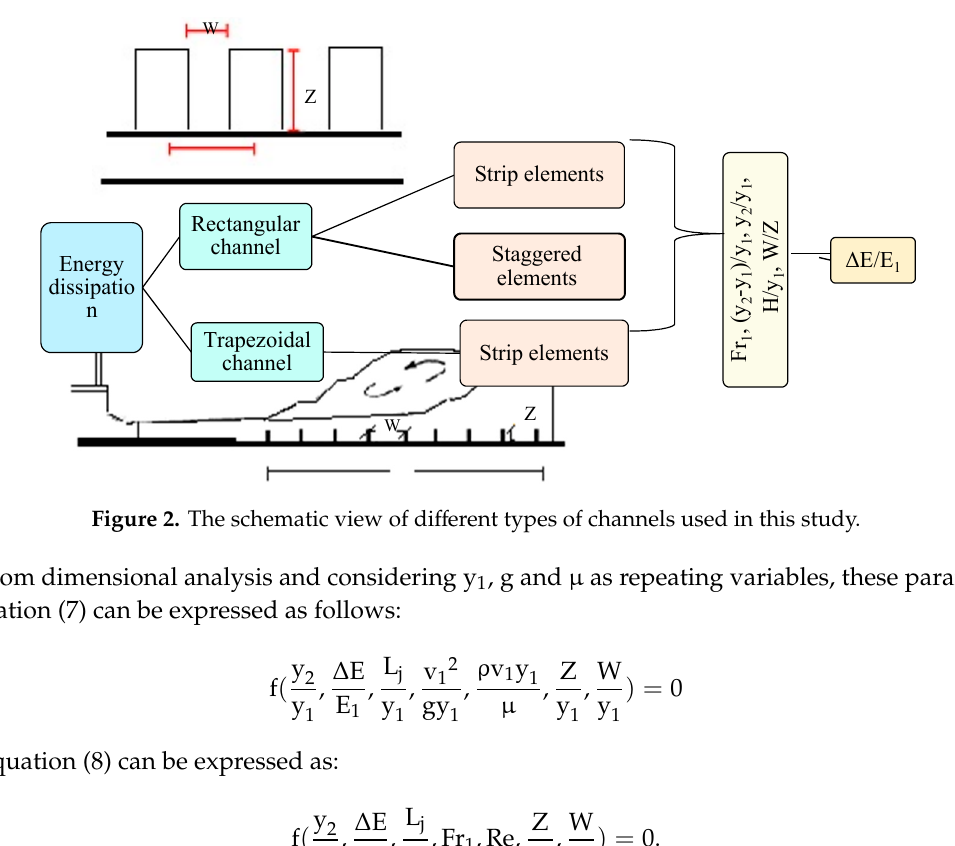
Table 2. Kernel Extreme Learning Machine (KELM)-developed Models.